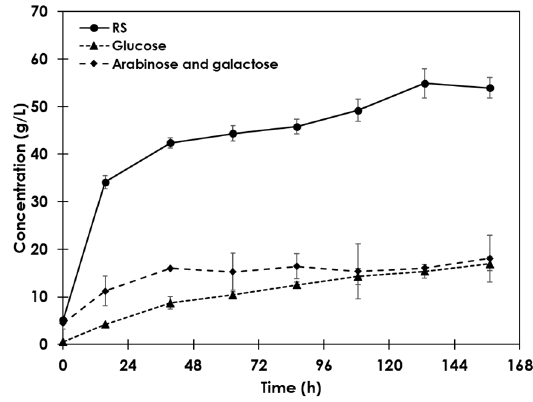
Figure 6. Evolution of reducing sugars concentration (circle), glucose (triangle), and the mixture arabinose and galactose (diamond) in enzymatic hydrolysate.